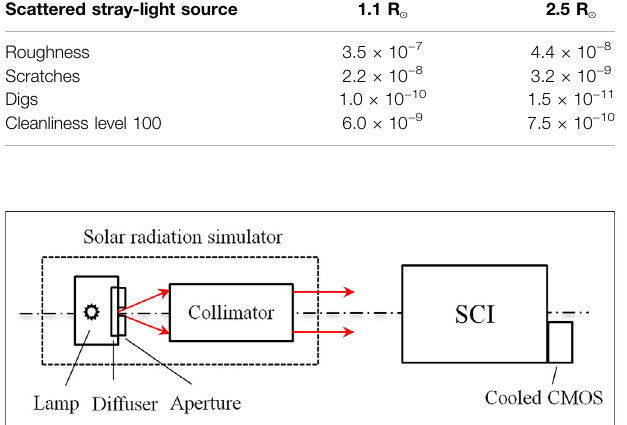
TABLE 1 | Summary of scattered stray-light level contributions at 700.0 nm. Scattered stray-light source